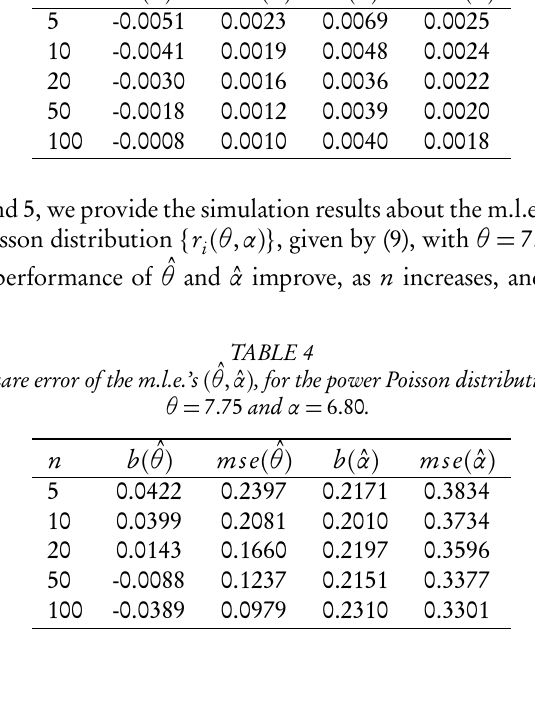
Bias and mean square error of the m.l.e.’s ( ˆ θ , ˆ α ) , for the power binomial distribution { r